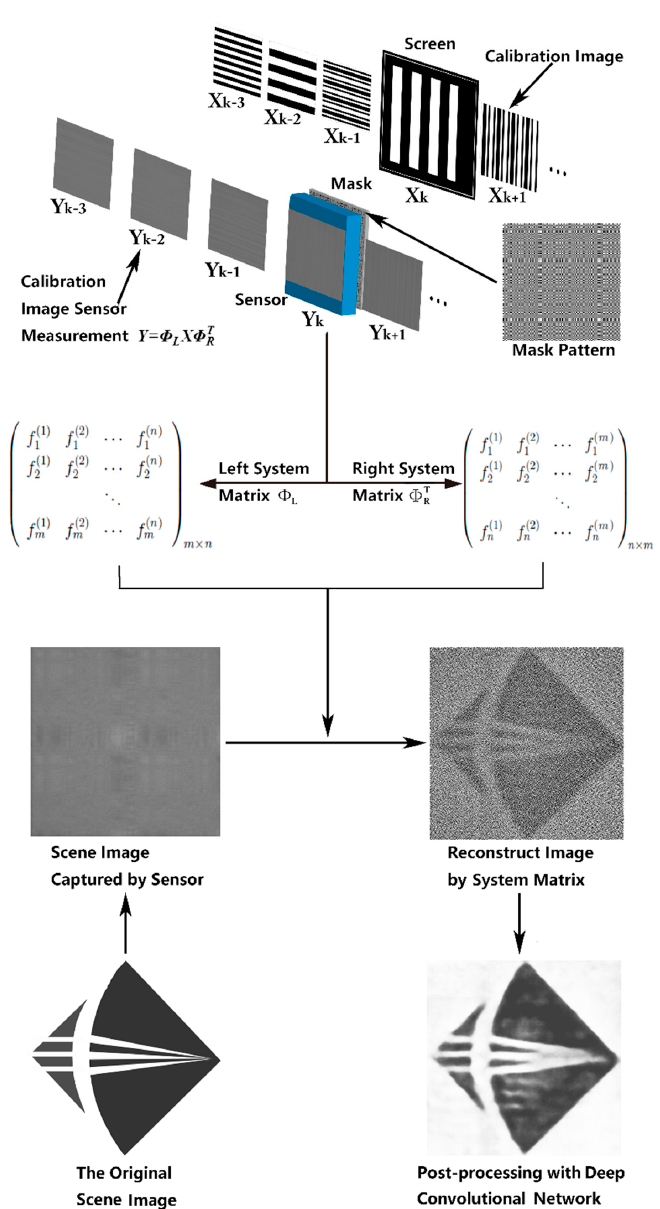
Figure 1. The overall process of image reconstruction and post-processing using a deep convolutional network. As is shown in the figure above, firstly, we used the calibration images measured by the sensor to calculate the left and right system transfer matrix iteratively, and then reconstruct the dataset images and the object images. Next, the dataset images were sent into the deep convolutional network for training, then the trained network was used to post-process the object image, then output the resulting image.